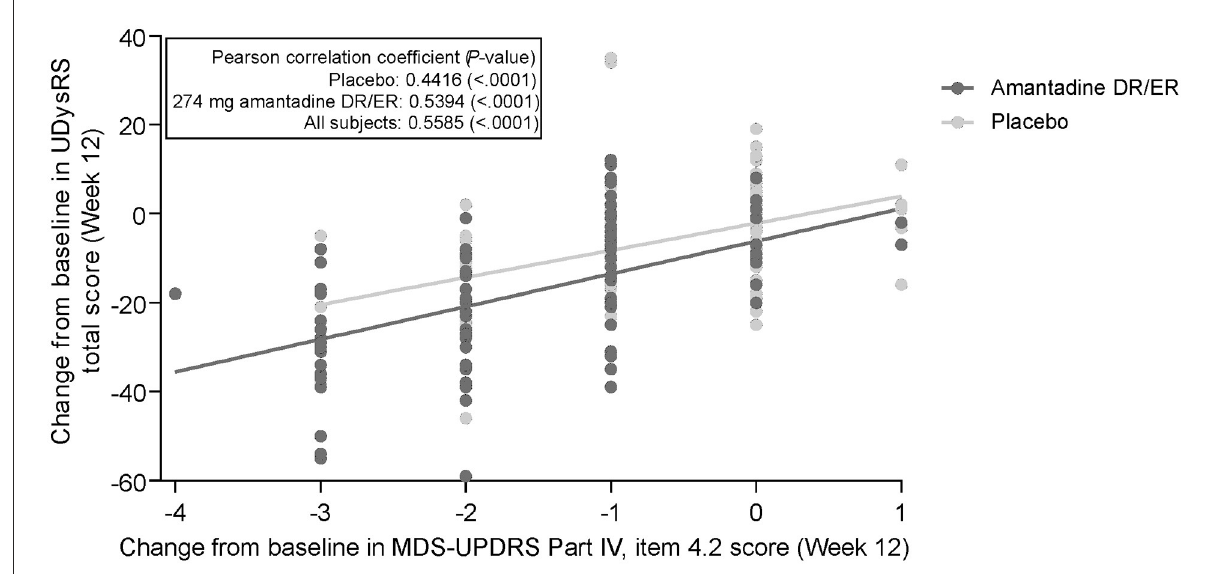
FIGURE1 Correlation of change from baseline in UDysRS total score and MDS-UPDRS Part IV, item 4.2. 274 mg amantadine base is approximately 340 mg amantadine hydrochloride. DR, delayed-release; ER, extended-release; MDS-UPDRS, Movement Disorder Society-Unified Parkinson’s Disease Rating Scale; UDysRS, Unified Dyskinesia Rating Scale.